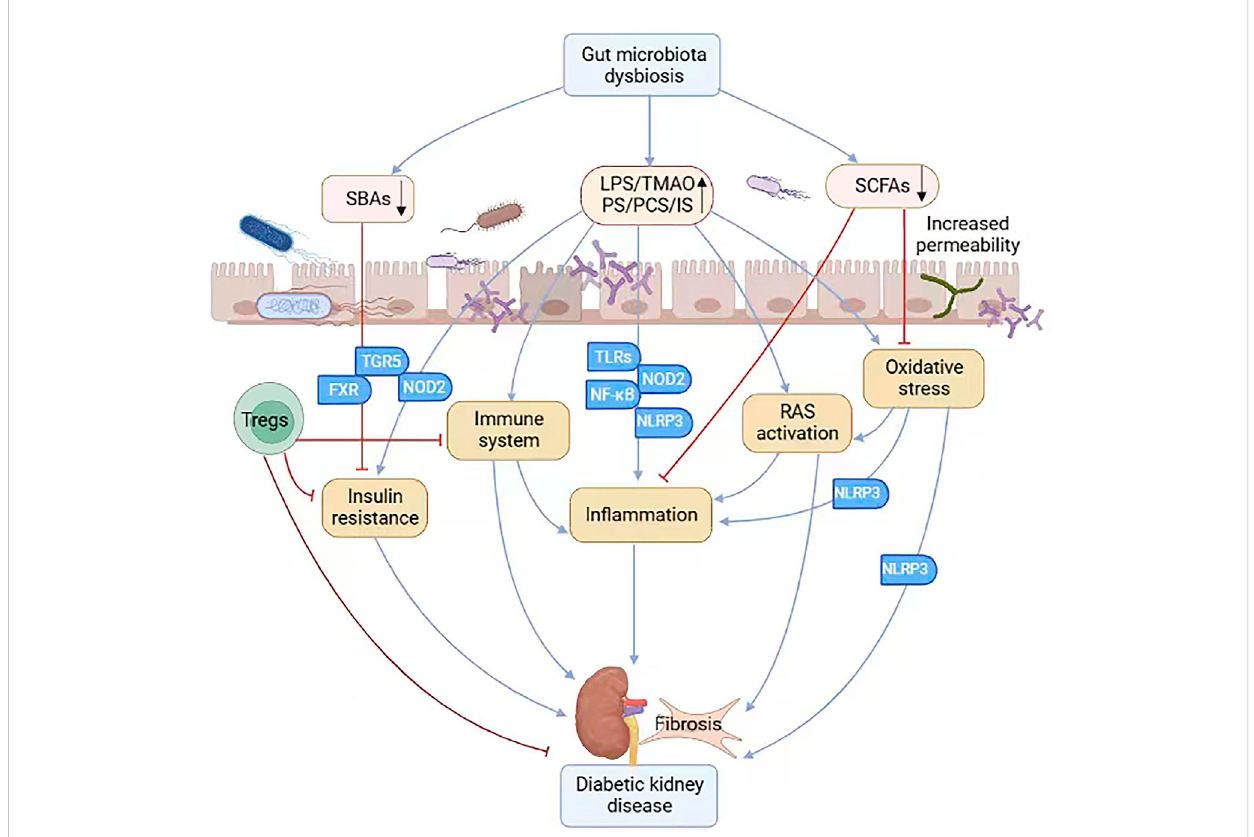
FIGURE 1 The gut-kidney axisinthepathogenesis ofDKD. Inpatients with diabetes, increased uremic toxinsinducegut microbiota dysbiosis, whichincreases the permeability of the epithelium and leads to increased exposure to uremic toxins and decreased production of SCFAs. Gut microbiota dysbiosis also induces de fi ciency of SBAs, which acts by binding to its receptor FXR and TGR5. The gut microbiota dysbiosis is involved in insulin resistance, RAS activation, oxidative stress, in fl ammation, immune system and fi brosis, contributing to the progression of diabetic kidney disease. (SCFAs, short- chainfattyacids;SBAs,secondarybileacids;FXR,nuclearfarnesoidXreceptor;TGR5,TakedaGprotein-coupledreceptor5;RAS,renalrenin-angiotensin system; Tregs, regulatory T cells; TLRs, Toll-like receptors; NOD2, nucleotide-binding oligomerization domain 2; NLRP3, nucleotide binding and oligomerization domain-like receptor family pyrin domain-containing